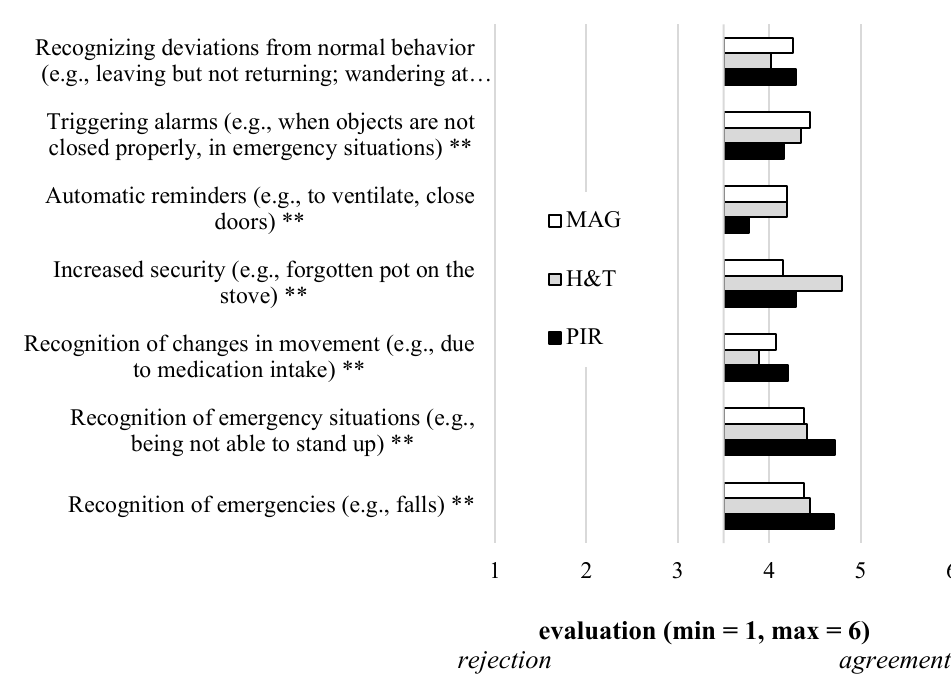
Figure 2. Users’ evaluation of perceived benefits of using three different sensor-based lifelogging technologies (RQ1).